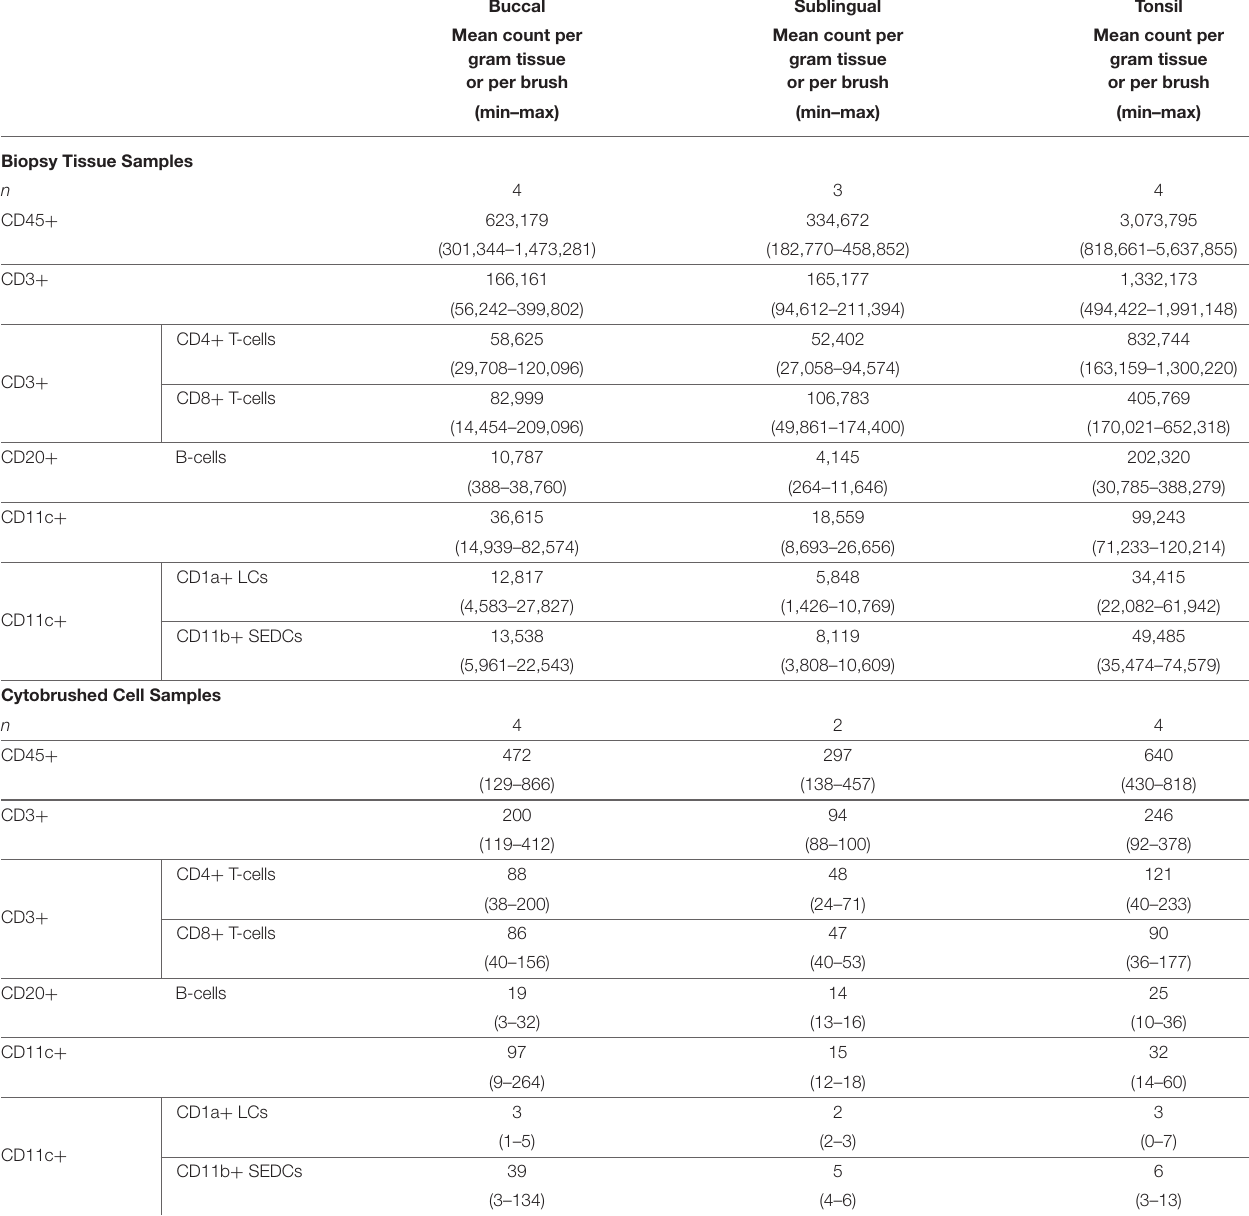
TABLE 1 | Immune cell counts per tissue mass or brushing from biopsied and brushed oral tissue